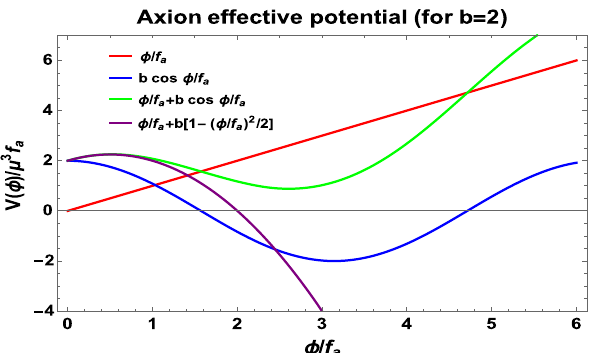
Fig. 3 Schematic behaviour of the axion effective potential obtained from String